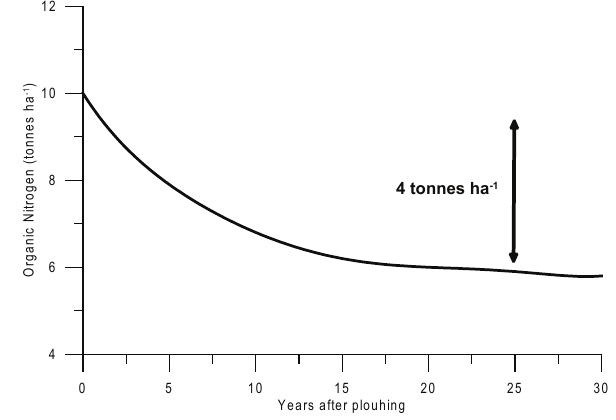
Fig. 4. Losses of soil organic nitrogen as a function of number of years after plowing permanent grassland in a temperate climate zone (UK). After 20 years, c.4tNha − 1 had leached from the nat- ural soil, 50% of that in the first 5.5 years (after Whitmore et al.,